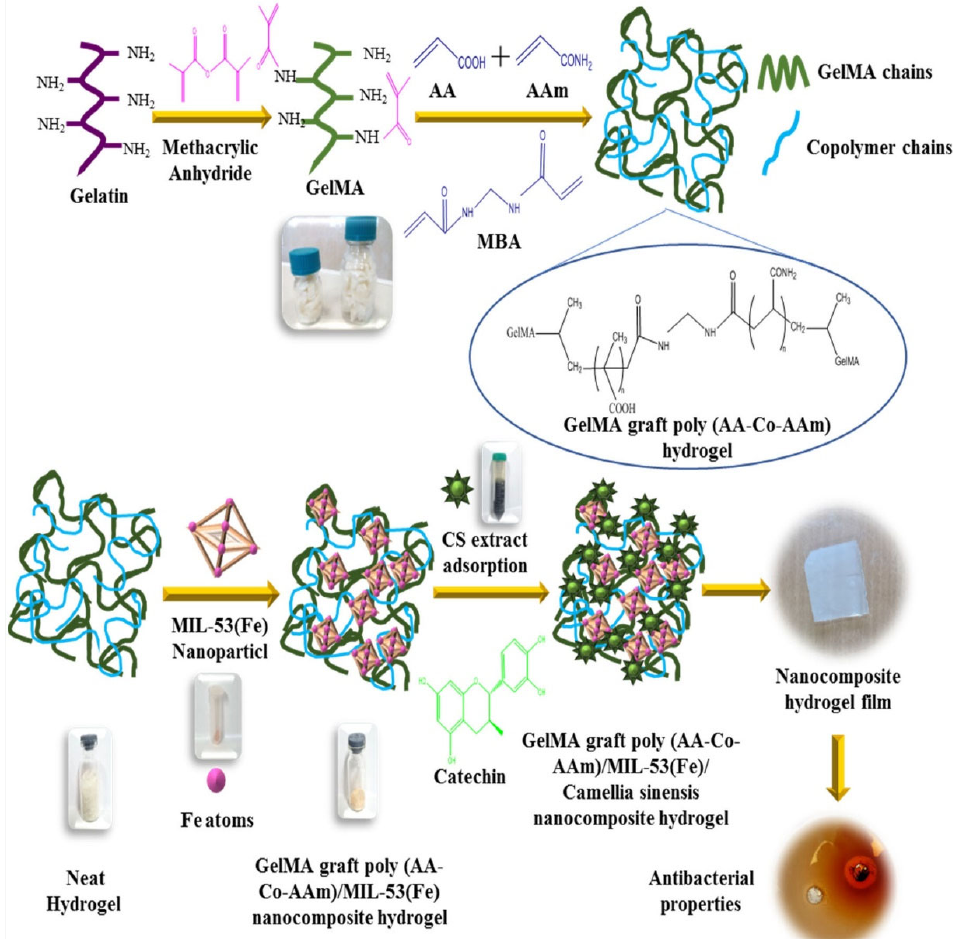
Figure 22. The scheme showing the synthesis of (GelMA-graft-poly(AA-co-AAm)/MIL-53(Fe)/CS extract). Top shows the preparation steps of GeIMA and copolymer chains, then, MIL-53(Fe) MOF is then incorporated to form the MOF–polymer composite. The composite is post-synthetically loaded with CS extract. The scheme shows pristine hydrogel, prior to adding MOFs to yield the nanocomposite. the nanocomposite was studied in vitro for its antimicrobial effect. Reproduced with permission from